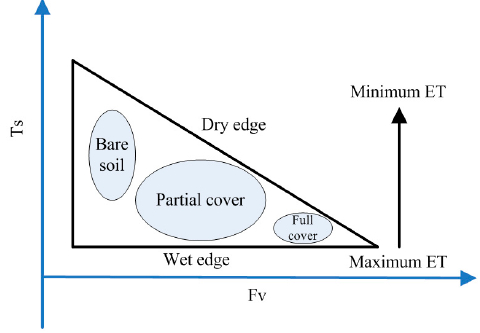
Figure 2. The idealized triangle space between Ts and Fv [138].